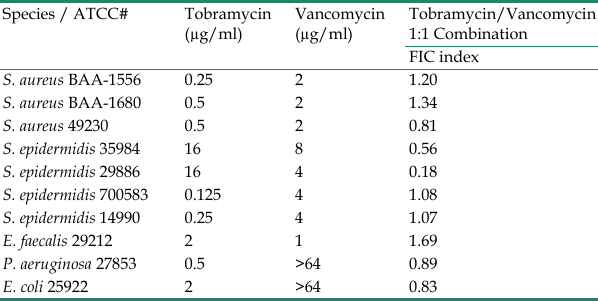
Table 1. Minimum inhibitory concentration (MIC) and fractional inhibitory concentration (FIC) index for musculoskeletal associated biofilms. FIC index val ues indicate synergistic (≤0.5), indifferent (0.5- 4), or antagonistic (≥4) drug interactions.